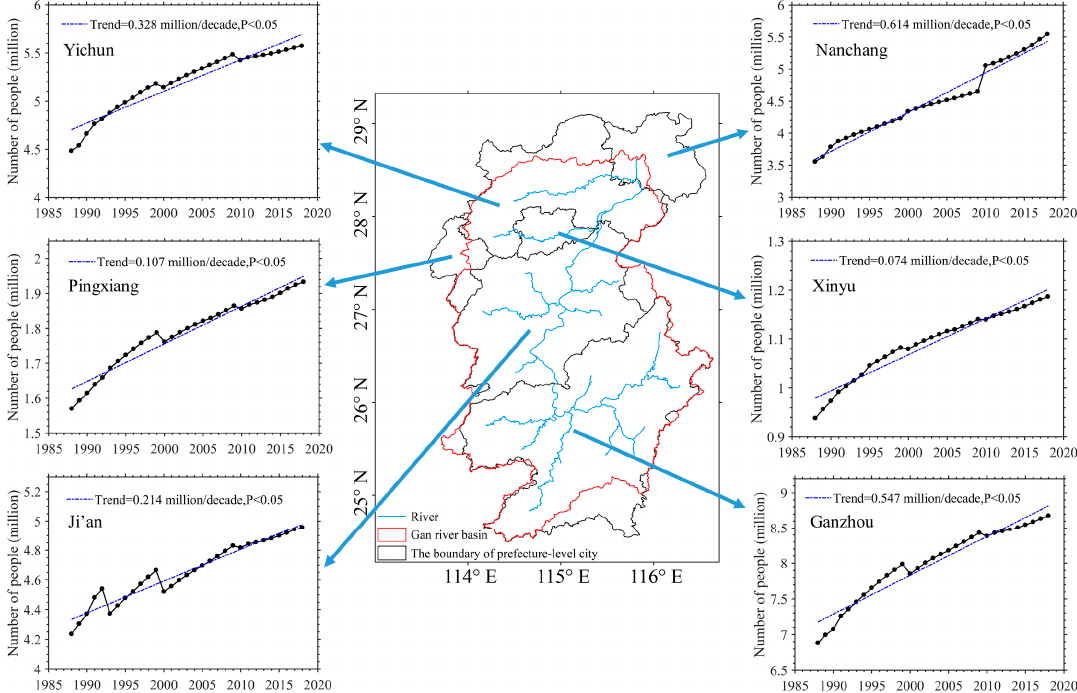
Figure 10. Annual population variations from 1988 to 2018 at the prefecture-level city scale in the GRB.